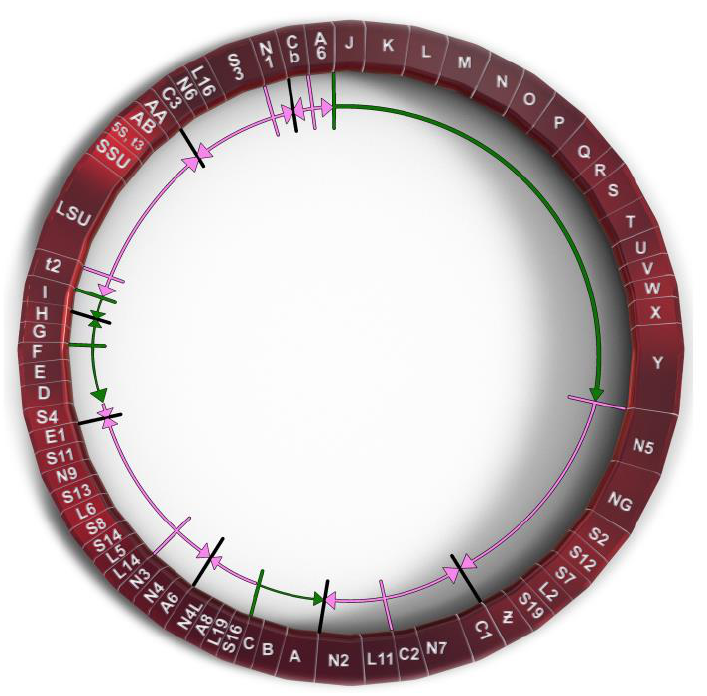
Figure 1. Genetic map of P. polycephalum ’s mtDNA showing its 72 genes. Gene symbols are as defined in Table 1. Genes which have their direction of potential transcription marked by green arrows are unassigned reading frames. Genes marked with pink arrows show the direction of transcription for classic mitochondrial